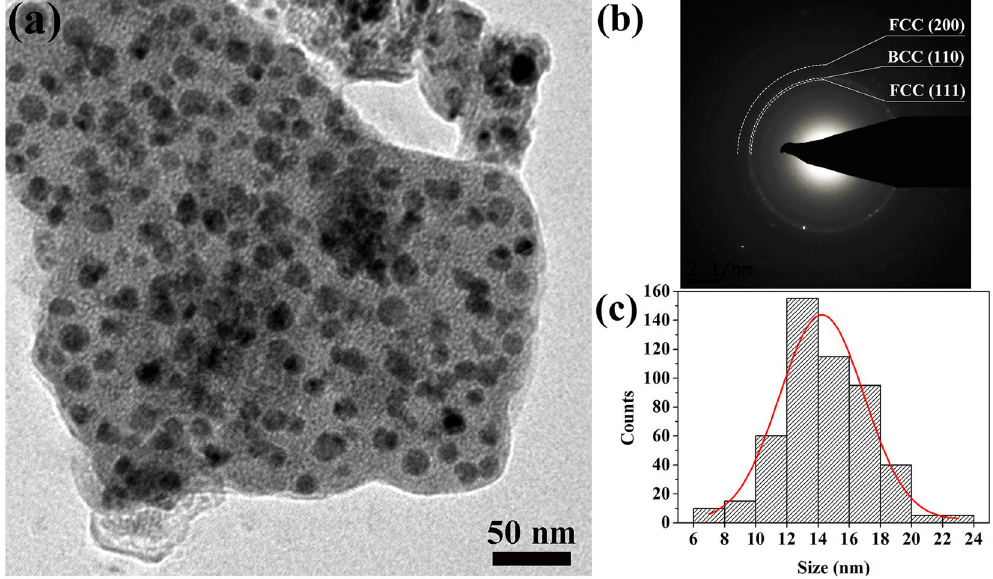
Figure 2. ( a ) TEM image of the prepared CoCrCuNiAl HEA; ( b ) corresponding SAED pattern; ( c ) histogram plot of the particle size